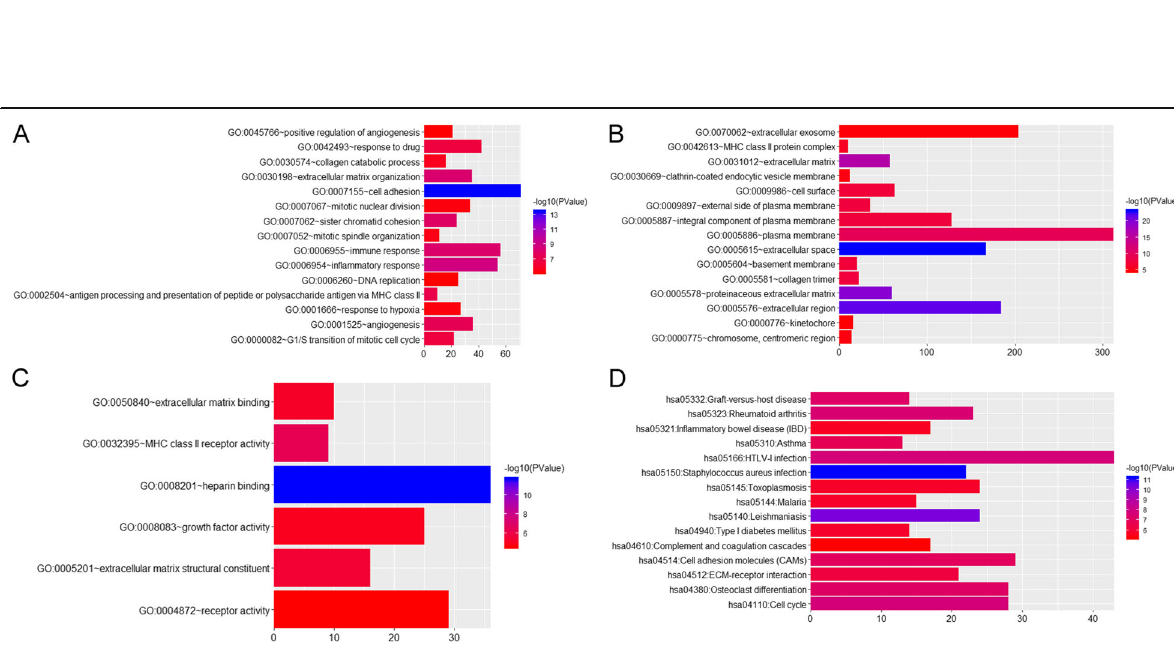
Fig. 3 Significantly enriched GO terms and KEGG pathways of DEmRNAs between OA and normal controls. a . BP, biological process; b . CC, cellular component; c . MF, molecular function; d KEGG pathways. The x-axis shows counts of DEmRNAs enriched in GO terms or KEGG pathways and the y-axis shows GO terms or KEGG pathways. The color scale represented -lg p